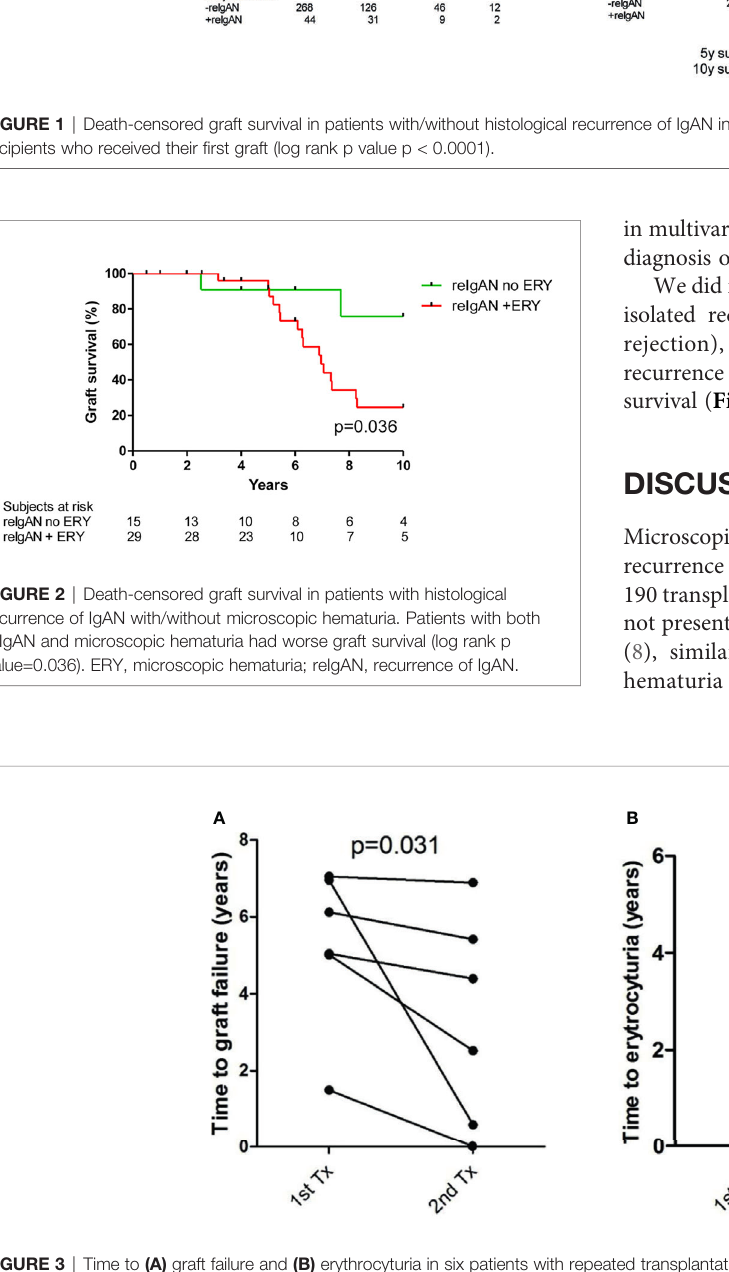
FIGURE 3 | Time to (A) graft failure and (B) erythrocyturia in six patients with repeated transplantation. Patients after second transplantation had shorter time to graft failure (p = 0.031) and nonsigni fi cantly shorter time to erythrocyturia (p = 0.094). Differences were calculated by Wilcoxon signed rank